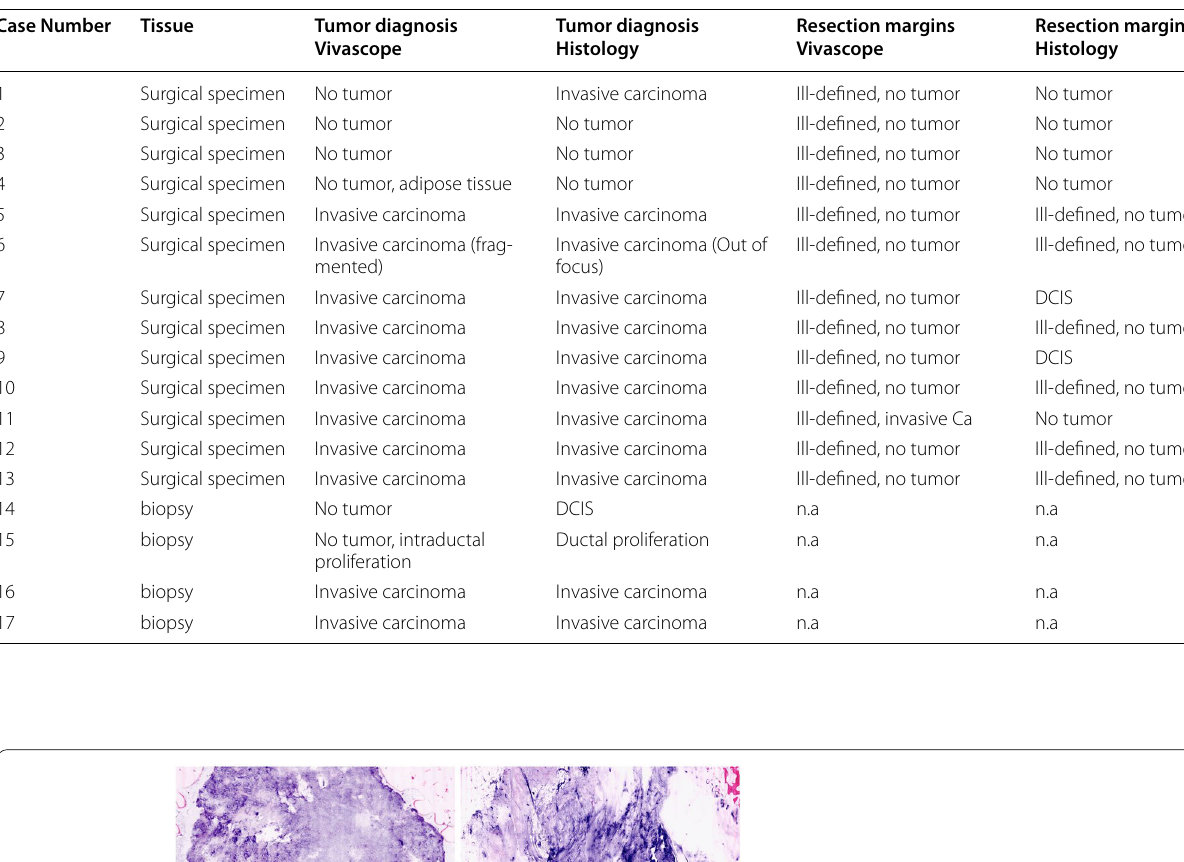
Table 1 Comparison between diagnostic outcome of FCM images and conventional histology